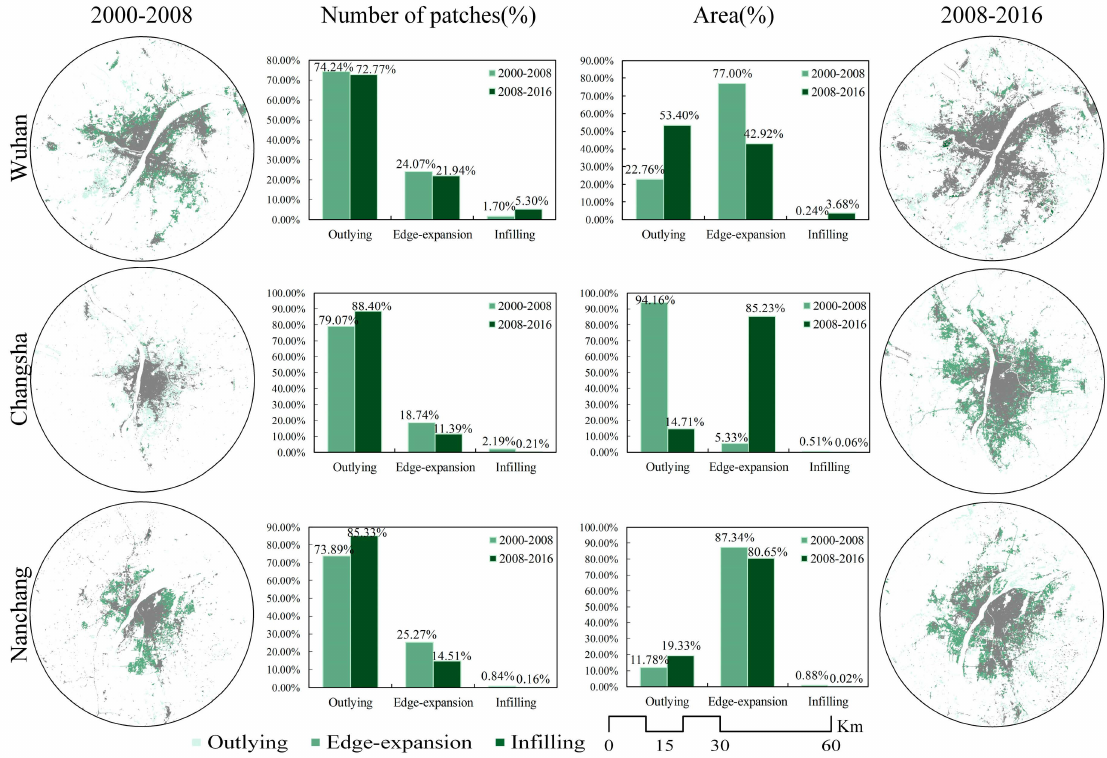
Figure 10. Spatial distributions of the three urban expansion types and the composition (%) of the three types of expansion for the number of patches and area of newly developed urban patches for the three capital